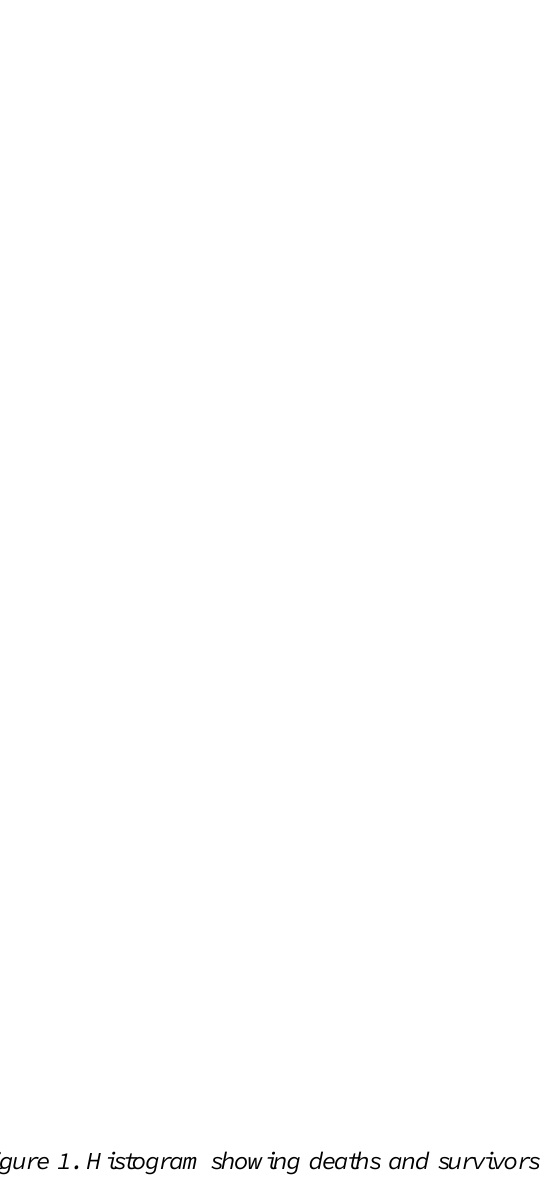
Figure 1 : Perforated Peptic Ulcer Mortality, UMHT